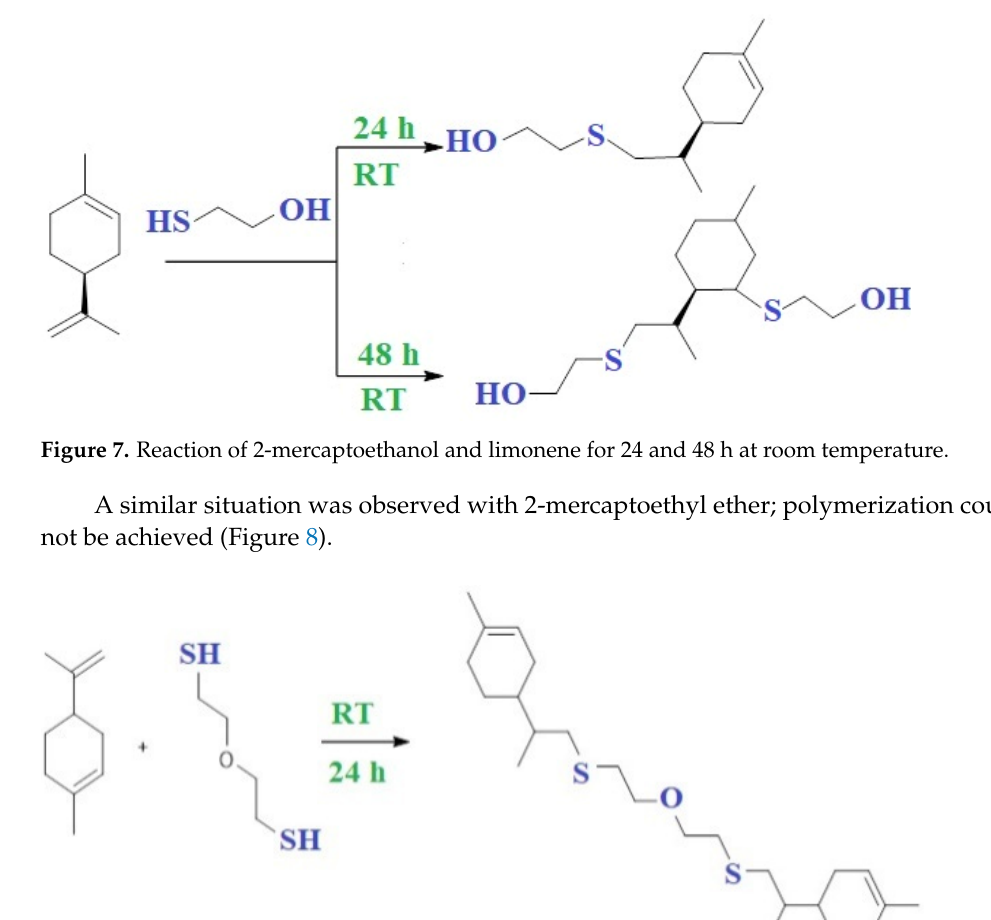
Figure 9. Scheme of the reaction of copolymerization of limonene with 2-mercaptoethyl ether using AIBN as an initiator.